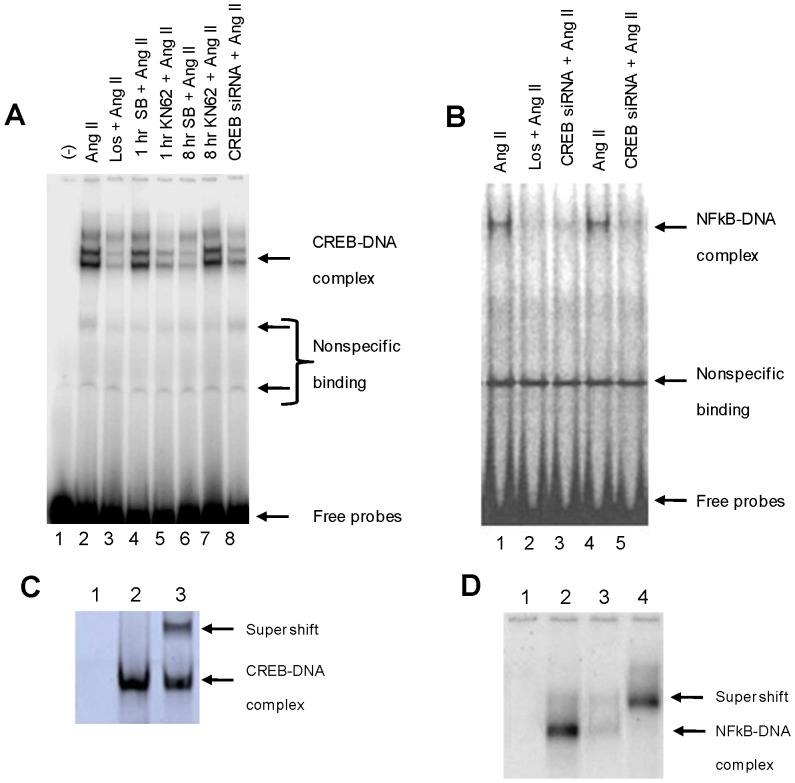
Ang II stimulates CREB and NF-κB binding to DNA.(A) CREB-DNA binding activity was determined under different treatment conditions using a CREB specific labeled probe. (Lane 1) No nuclear extract (negative control). (Lane 2) Ang II (100 nM). (Lane 3) Losartan (1 µM)+ Ang II (100 nM). (Lane 4) SB203580 (20 µM) + Ang II (100 nM) at 1 hour. (Lane 5) KN62 (10 µM)+ Ang II (100 nM). (Lane 6) SB203580 (20 µM) + Ang II (100 nM) at 8 hour. (Lane 7) Non-transfected cells (Ang II (100 nM). (Lane 8) Transfected cells (CREB siRNA)+ Ang II (100 nM). (B) To study the synergistic actions of CREB and NF-κB, we conducted EMSA reactions, using NF-κB specific labeled probes under different conditions. (Lane 1) Ang II (100 nM). (Lane 2) Losartan (1 µM)+ Ang II (100 nM). (Lane 3) Transfected cells (CREB siRNA)+ Ang II (100 nM). (Lane 4) Ang II (100 nM). (Lane 5) Transfected cells (CREB siRNA)+ Ang II (100 nM). (C) To confirm the specificity of the CREB-DNA binding bands we did competitive (Lane 1) and supershift assay (Lane 3) using anti CREB antibody, compared to normal CREB-DNA binding (Lane 2). (D) To confirm specificity of the NF-κB -DNA bands, we similarly performed competitive assay (Lane 3) and supershift assay using anti-p65 antibody (Lane 4). Normal binding and negative control using no nuclear lysate are also included (Lane 2 and Lane 1, respectively).